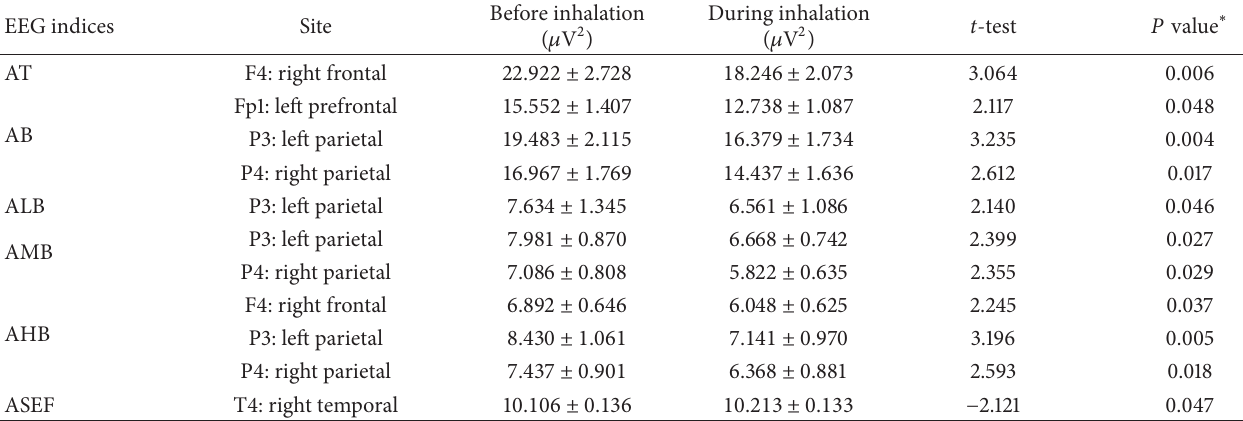
Table 4: Effect of uninasal (left nostril) inhalation of essential oil of A. koreana twigs on EEG activity in both genders.